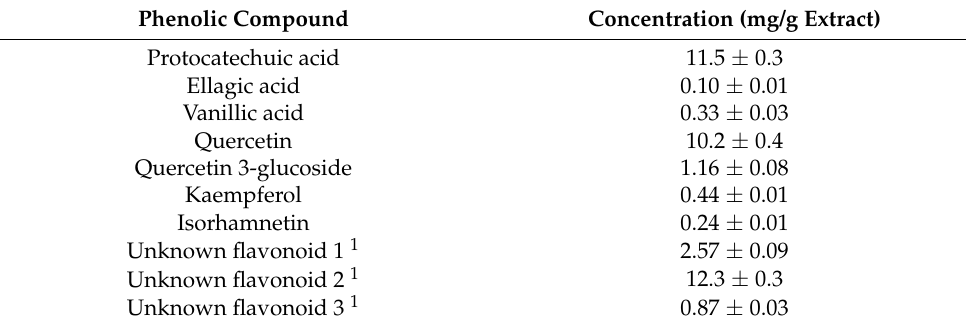
Table 1. Phenolic composition of extracts obtained from onion household wastes.